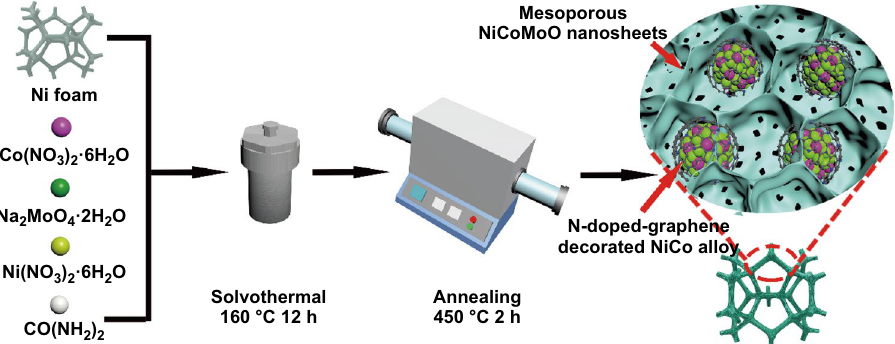
Fig. 1 Schematic for the synthesis of